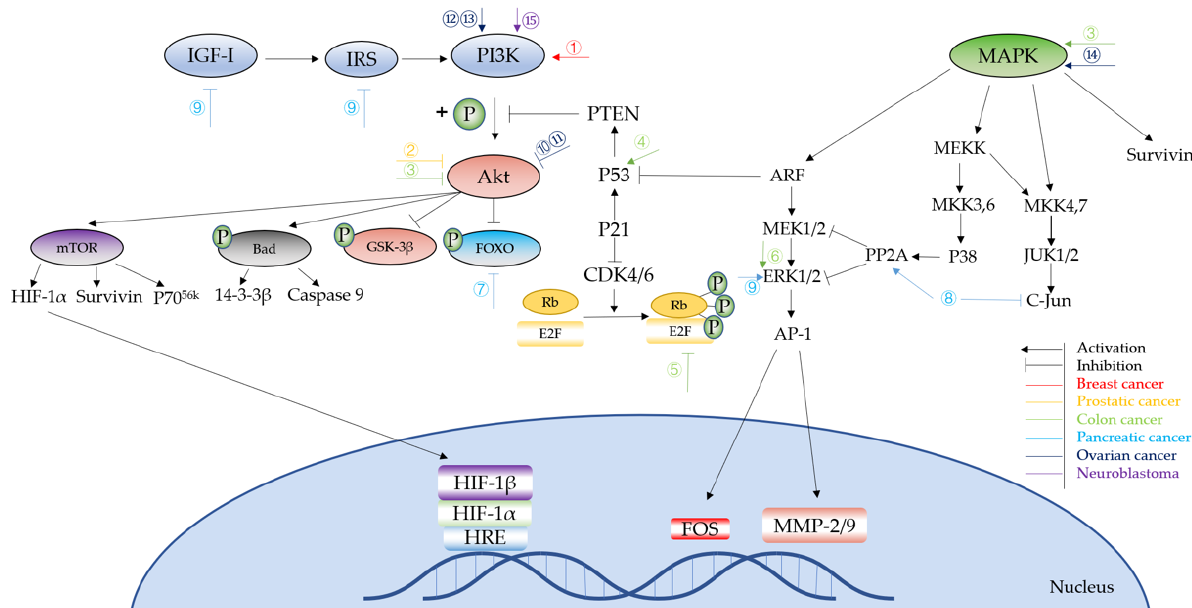
Figure 3. Signaling pathway s of NO in different cancer types. ① Pretreatment: NOS2 Result: block apoptosis.